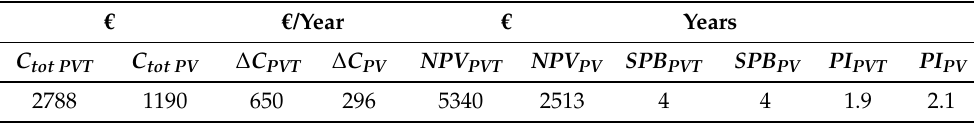
Table 5. Yearly energy results. Table 6. Yearly economic results.